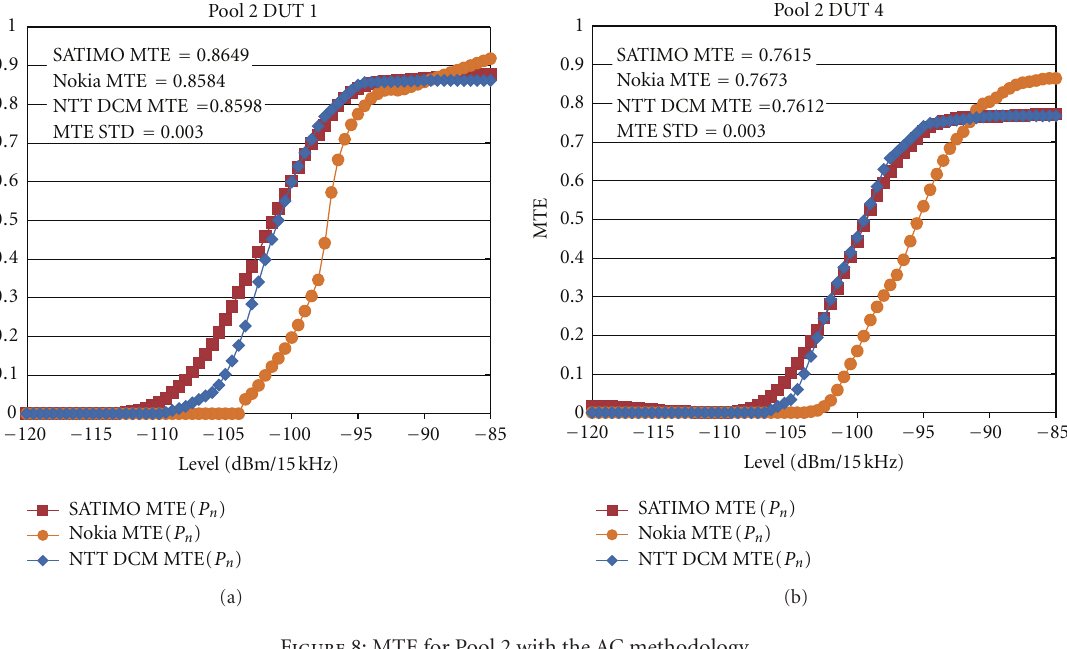
Figure 8: MTE for Pool 2 with the AC methodology.